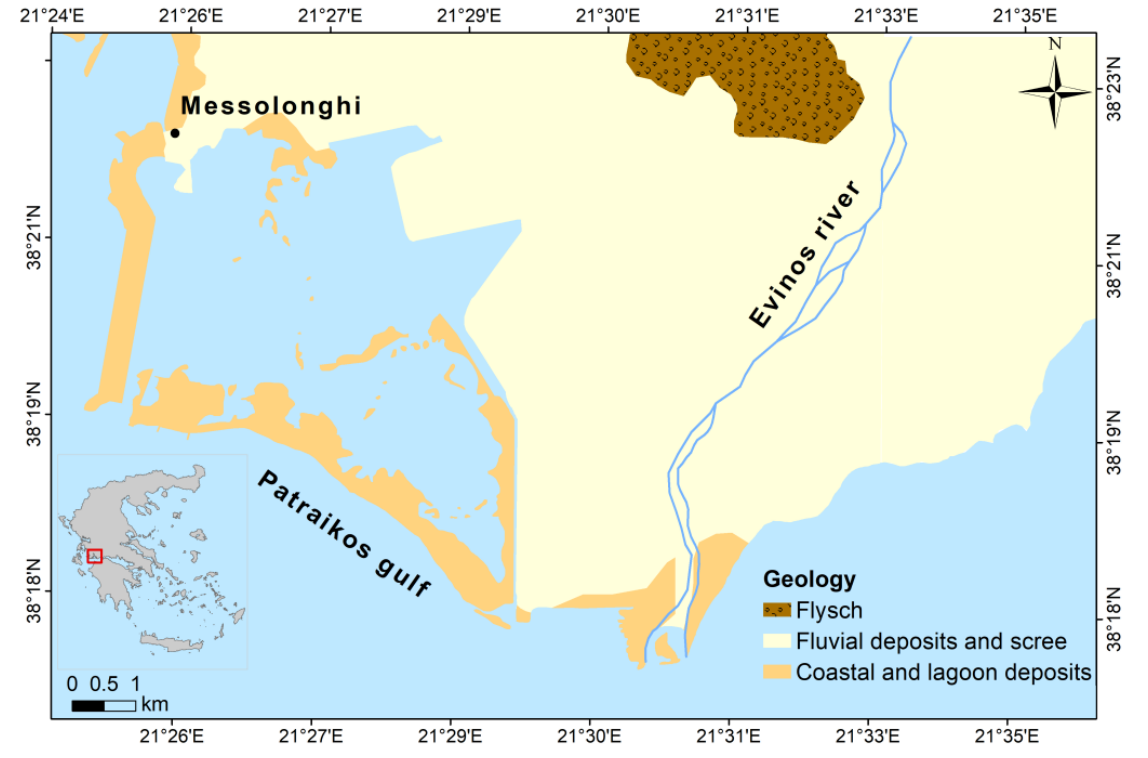
Figure 1. Study area showing the main geology.